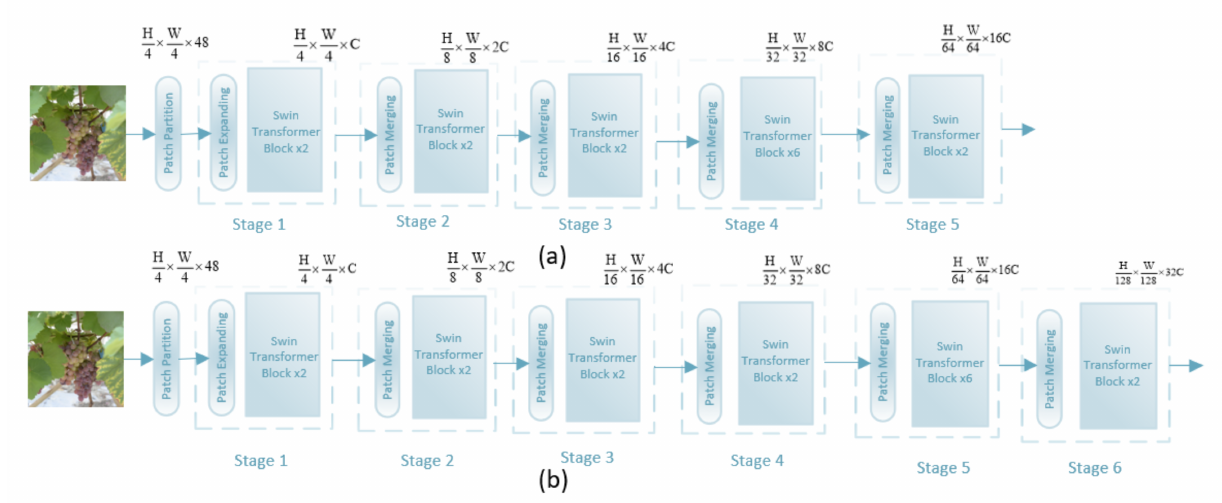
Figure 4. Swin Transformer architecture with different stages: ( a ) 5 stages; ( b ) 6 stages.